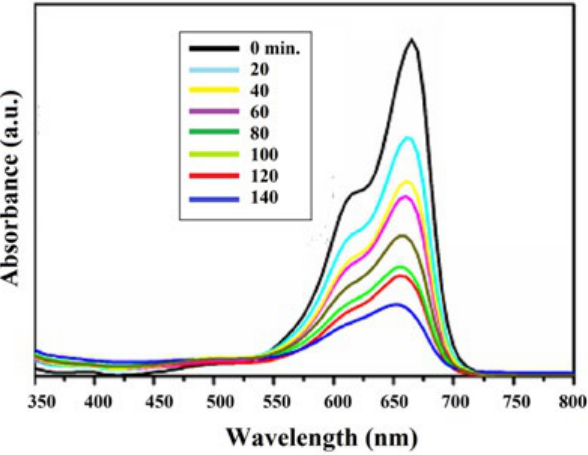
Fig. 9: Absorption spectra of the MB solution taken at different photocatalytic degradation times using NG@CoFe 2 O 4 as photocatalyst